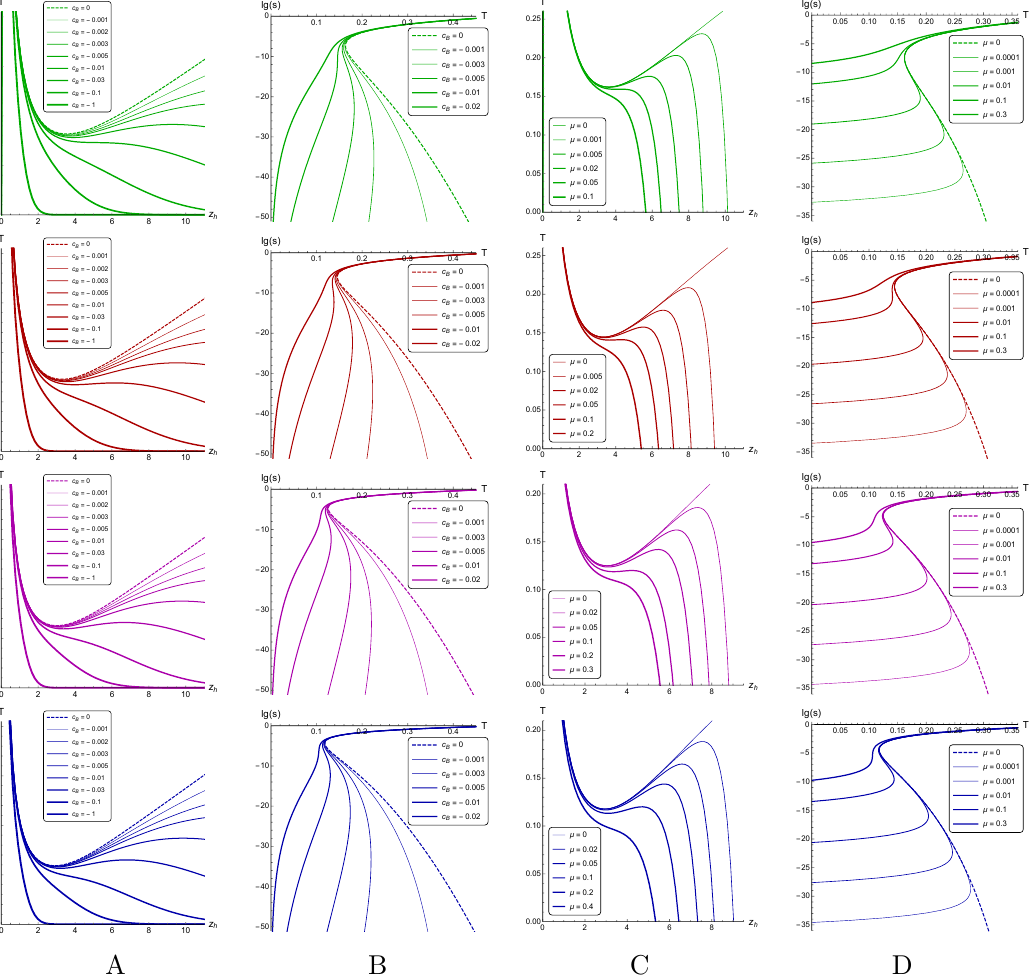
Figure 6 . Temperature T ( z h ) (A) and entropy s ( T ) in logarithmic scale (B) for different c B , µ = 0 ; temperature T ( z h ) (C) and entropy s ( T ) in logarithmic scale (D) for different µ , c B = − 0 . 001 ; ν = 1 (1-st line), ν = 1 . 5 (2-nd line), ν = 3 (3-rd line) and ν = 4 . 5 (4-th line), c = 0 . 227